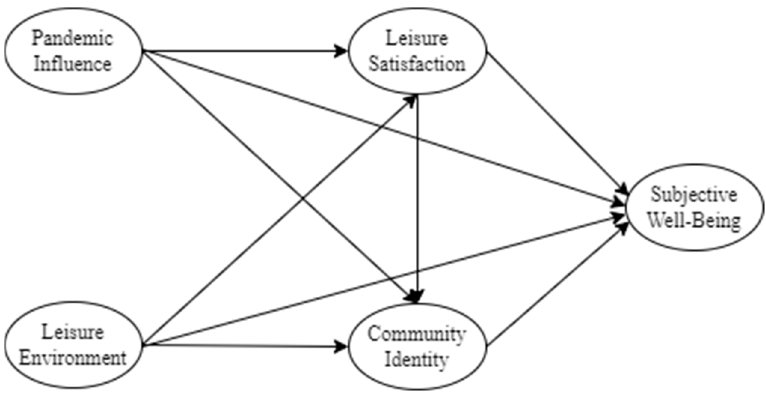
Figure 1. Our conceptual model.